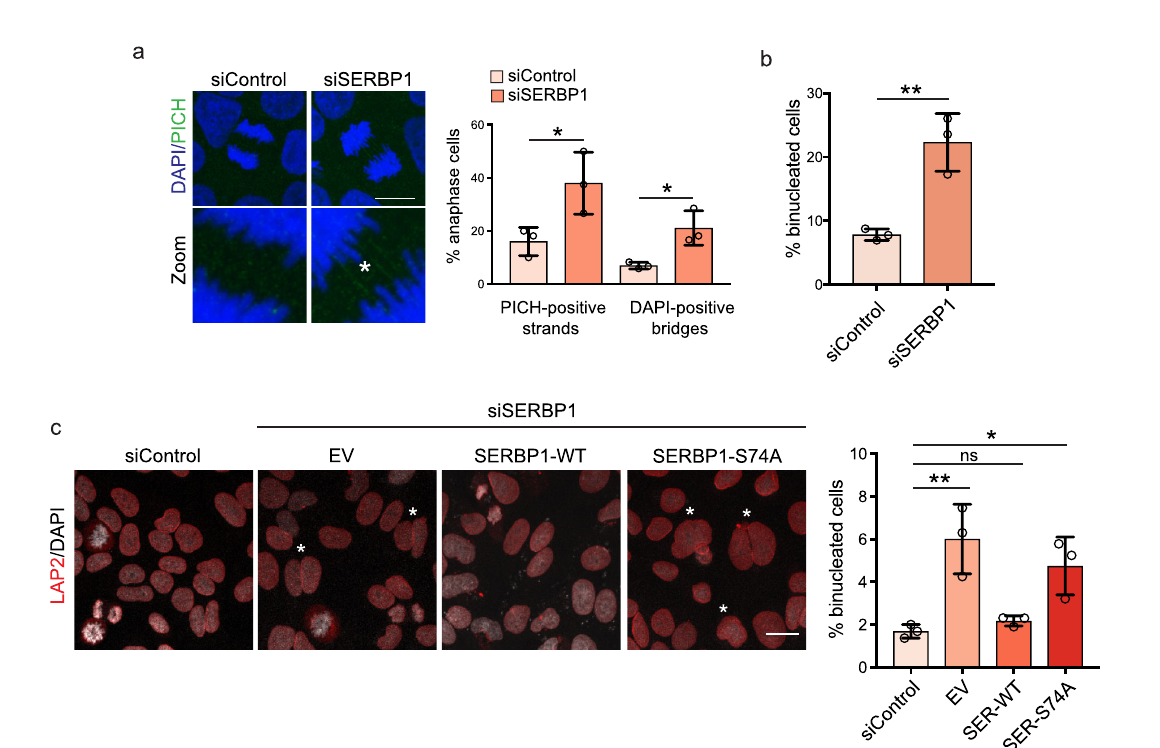
Fig. 6 PKC ε regulates protein translation in mitotic cells. a DLD1 cells treated for 1 hour with DMSO, 10 μ g/ml cycloheximide or 20 μ g/ml puromycin. SERBP1 is detected in green, FMRP in magenta and DNA in blue (DAPI). Scale bar, 10 μ m. b Quanti fi cation of M-bodies per cell under the conditions described. n = 15 cells examined in three independent experiments. Error bars, mean ± SD. One way-ANOVA and Tukey ’ s multiple comparisons test, ** p = 0.003, ns = 0.75. ( c ) After 1-hour treatment with DMSO or 500 nM Blu577, 20 μ g/ml puromycin was added for 1 hour to DLD1 cells. SERBP1 M-bodies are detected in green, α -Tubulin in magenta and DNA in blue (DAPI). Scale bar, 10 μ m. d Number of M-bodies per cell are quanti fi ed under the conditions indicated. n = 15 cells examined over 3 independent experiments. Error bars, mean ± SD. e Western blot analysis of 2 S (second supernatant), 3 P (third pellet) and 3 S (third supernatant) fractions obtained from DLD1 treated for 1 h with DMSO or 500 nM Blu577 and then treated 1-h with 20 μ g/ ml puromycin. Samples were immunoblotted for LARP4B, FMRP, G3BP and SERBP1. The 3 S fraction containing the M-bodies is indicated by the red rectangles. f Ribopuromycylation assay in DLD1 cells synchronised in mitosis, isolated following mitotic shake off, treated with 50 μ g/ml Puromycin and 100 μ g/ml Cycloheximide for 5 min and blotted using the anti-Puromycin antibody. MPM2 staining is used to con fi rm mitotic enrichment and α -Tubulin is used as loading control. On the right, quanti fi cation of puromycin expression in DMSO- or 500 nM Blu577-treated mitotic cells for 1 h. α -tubulin has been used as a housekeeping control. Error bars, mean ± SD of n = 3 independent experiment. Unpaired t test, ** p = 0.001. Source data are provided as a Source Data fi le.